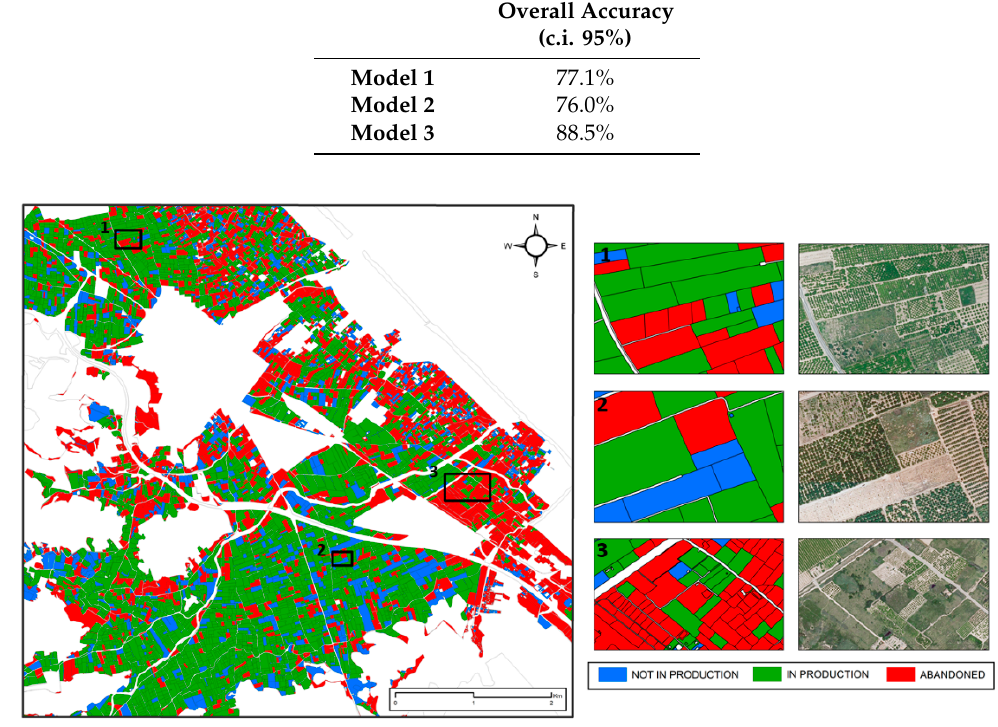
Figure 7. Model 3 Figure 7. Model 3 map.